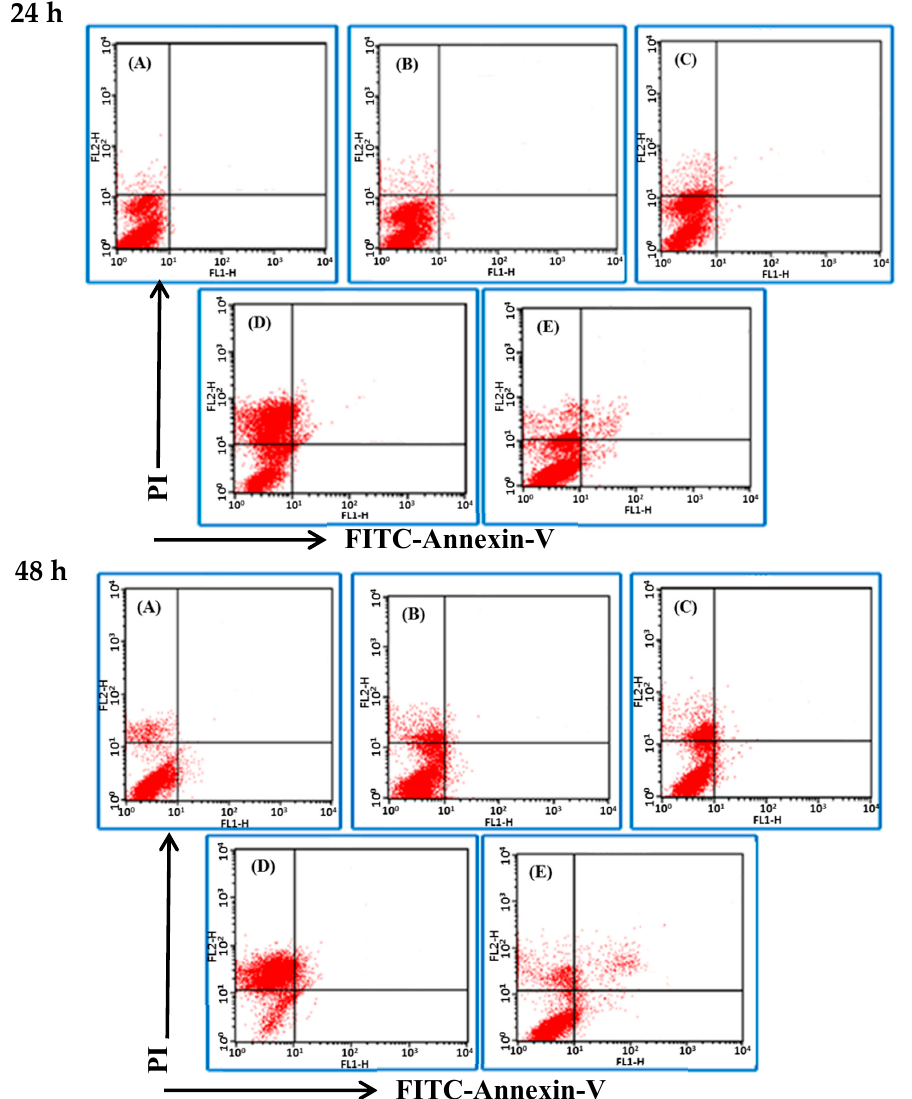
Figure 3. Effects of BSE on H661 cell death pattern under the treatment of different durations (24 and 48 h) and different concentrations of BSE: ( A ) 0 µ g/mL (Control), ( B ) 22 µ g/mL, ( C ) 44 µ g/mL, ( D ) 88 µ g/mL, ( E ) Cisplatin in 100 µ g/mL. Lower left (LL) quadrant: viable cells; upper left (UL) quadrant: necrotic cells; lower right (LR) quadrant: early apoptotic cells; upper right (UR) quadrant: late apoptotic